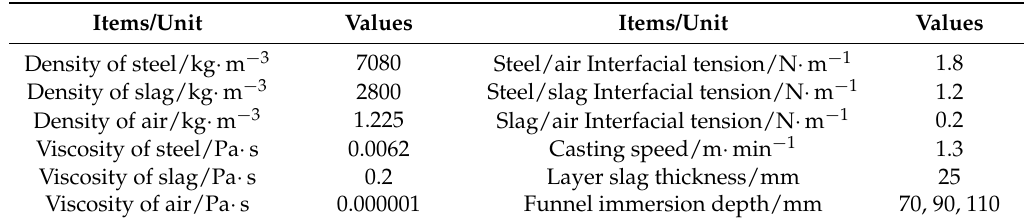
Figure 4. Grid ( a ), calculated domain schematic ( b ), and conditions of initial distribution for simulated phases ( c